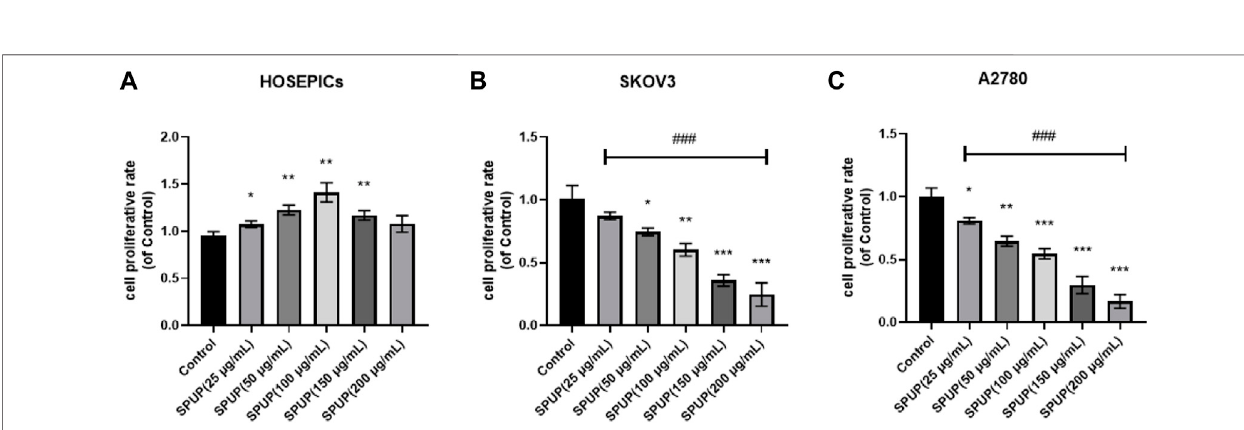
Frontiers in Materials |